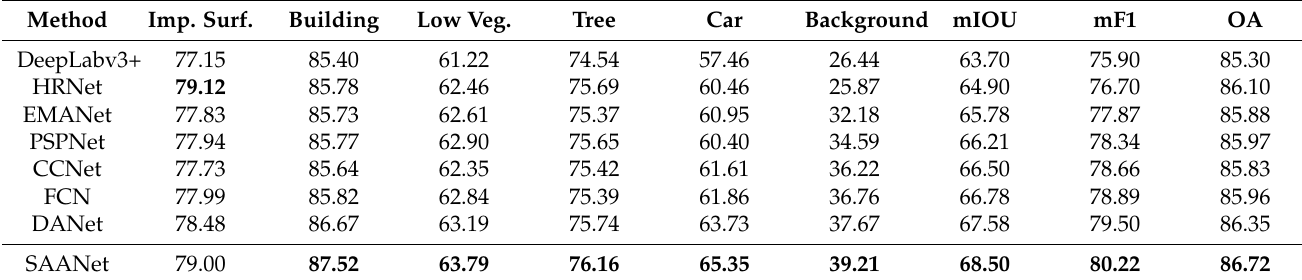
Table 1. Comparisons of different networks on ISPRS Vaihingen dataset. Note that we chose the IOU as the metric of each category. The best results are shown in boldface.